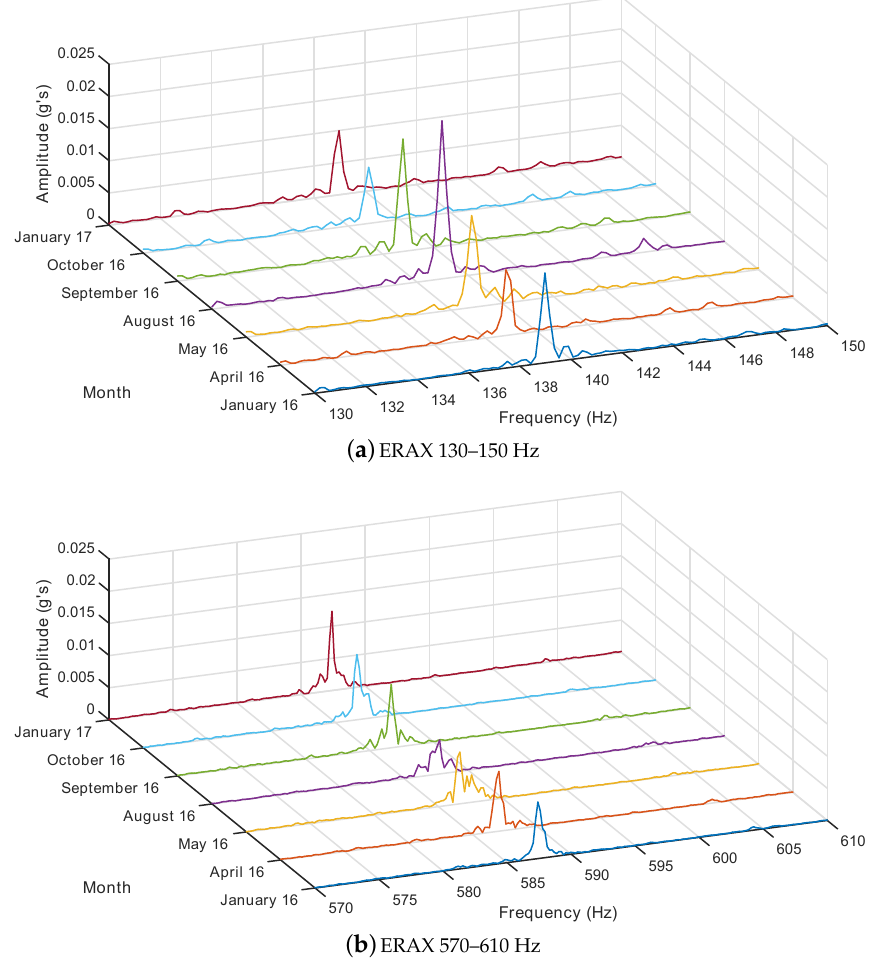
Figure 5. January 2016–January 2017. Evolution of gear-mesh frequencies at super-synchronous speed. Shaft unbalance or misalignment shows up at the rotational speed of the shaft and its harmonics. Phase measurements are usually used in order to distinguish between various types of misalignment or unbalance. As explained in Section 3.2, the vibration amplitude of the second harmonic of the rotational speed must be higher than 50% of the first harmonic in order to diagnose coupling damage. For pure unbalance, a higher than normal amplitude at the frequency of the rotational speed appears in the frequency